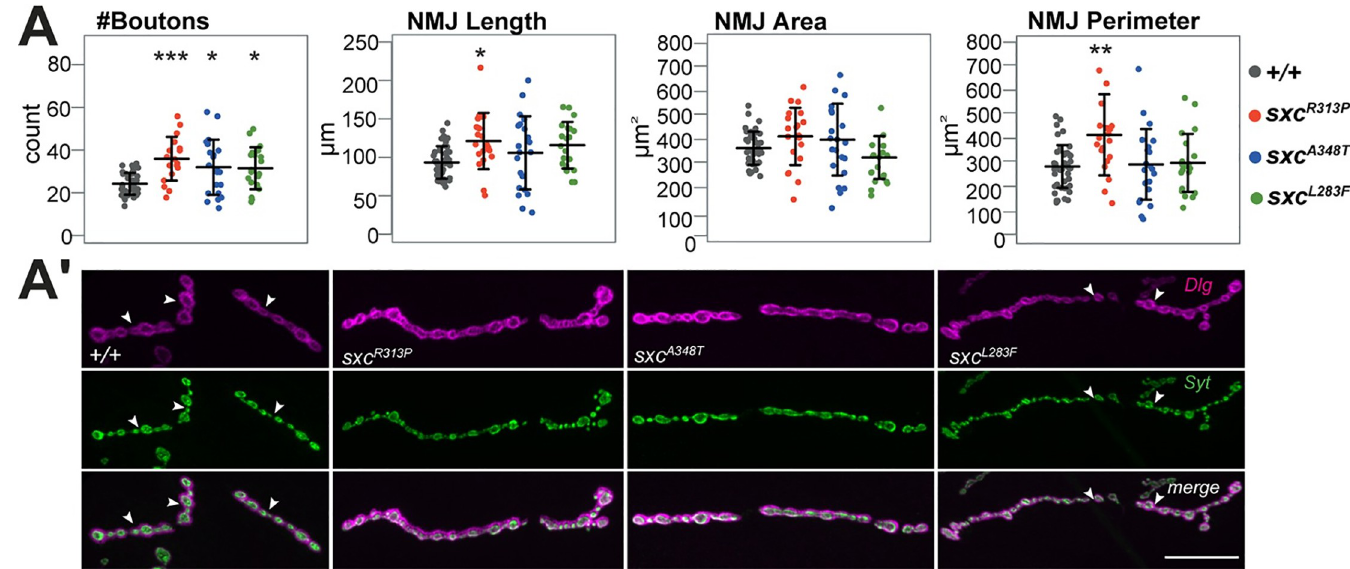
Fig 5. Synaptic morphology of sxc R313P , sxc A348T and sxc L283F . Data presented as individual data points with mean ± SD. (A) NMJs on muscle 4 of sxc R313P , sxc A348T and sxc L283F larvae have a significantly higher number of synaptic boutons ( sxc R313P : N = 21, p = 6.8x10 -5 , in red; sxc A348T : N = 21, p = 0.011, in blue; sxc L283F : N = 20, p = 0.0225) compared to the control ( +/+ , N = 42, in grey). sxc R313P larvae have also significantly higher NMJ length (p = 0.0125) and perimeter (p = 0.001).). � p adj < 0.05, �� p adj < 0.01, ��� p adj < 0.001, based on one-way ANOVA with Tukey’s multiple comparisons test. A complete list of p-values and summary statistics is provided in S3 Table . (A’) Representative NMJs of wandering third instar larvae labeled with anti-discs large 1 ( Dlg , magenta) and anti-synaptotagmin ( Syt , green). When appropriate, type 1b synapses are distinguished from other synapses with white arrow. Scale bar , 20 μ m. The quantitative parameter values of the representative images ( +/+ | sxc R313P | sxc A348T | sxc L283F ): #Boutons (20 | 36 | 29 | 37), Length (84.5 | 113.8 | 107.4 | 128), Area (399 | 447.9 | 360.9 | 349.9), Perimeter (254.2 | 329.5 | 313.8 |